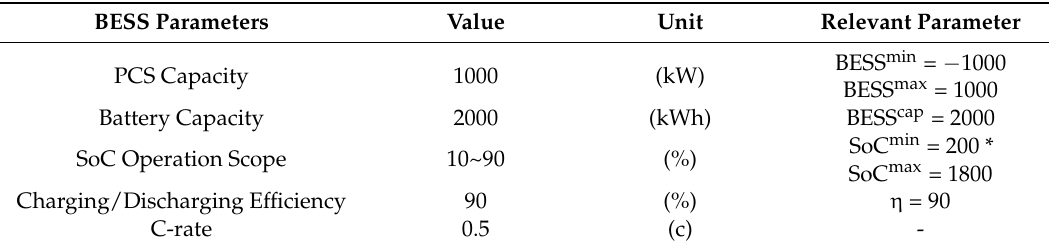
Table 2. BESS’s specifications and relevant